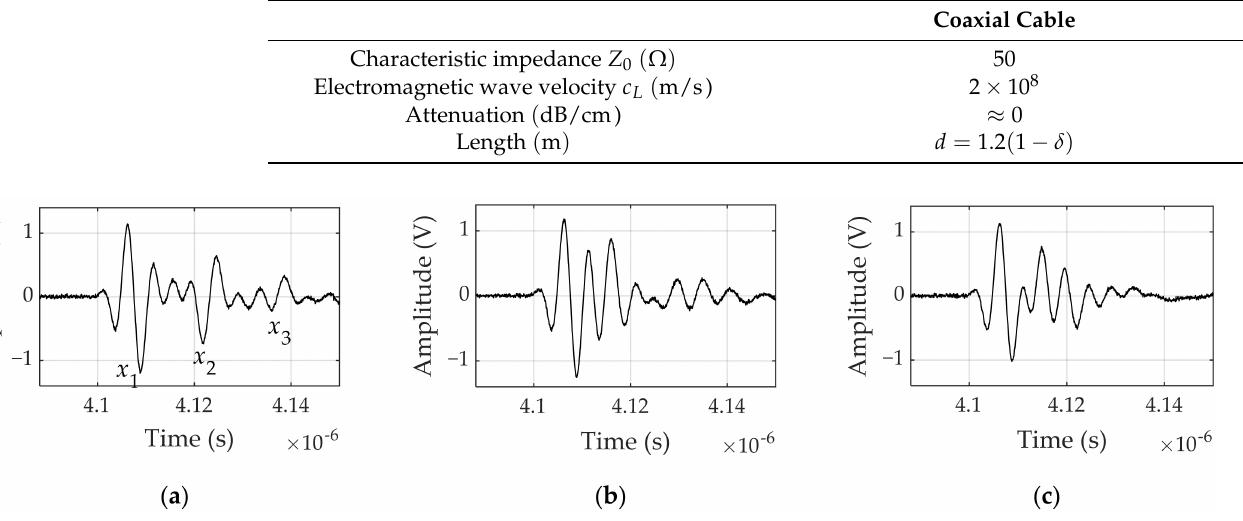
Figure 15. AMI signals with different degrees of overlap: ( a ) δ = − 25%; ( b ) δ = 50%; ( c ) δ = 60%.